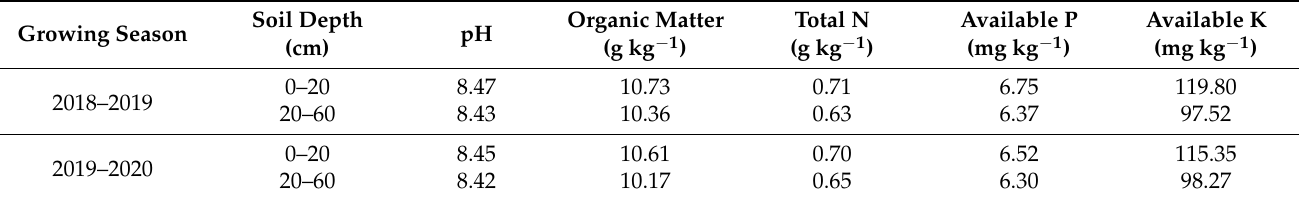
Table 2. Basic physicochemical properties of experimental